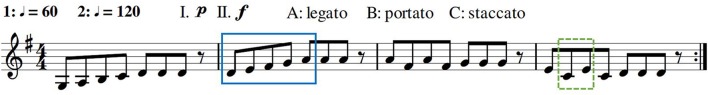
Melody played by the clarinettists, in variations of tempo, dynamic level and articulation. In the blue rectangle, the notes shown in Figures 3, 4; in dashed-green, the note transition shown in Figure 7.